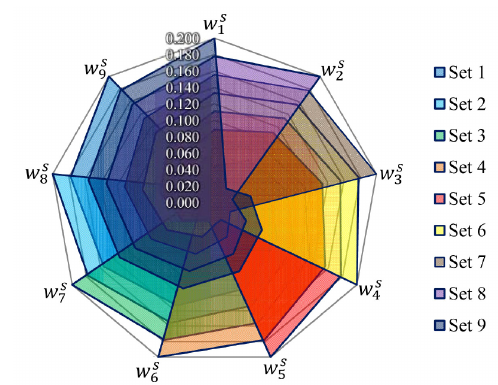
Figure 4. The wavering pattern of criteria weights for sensitivity